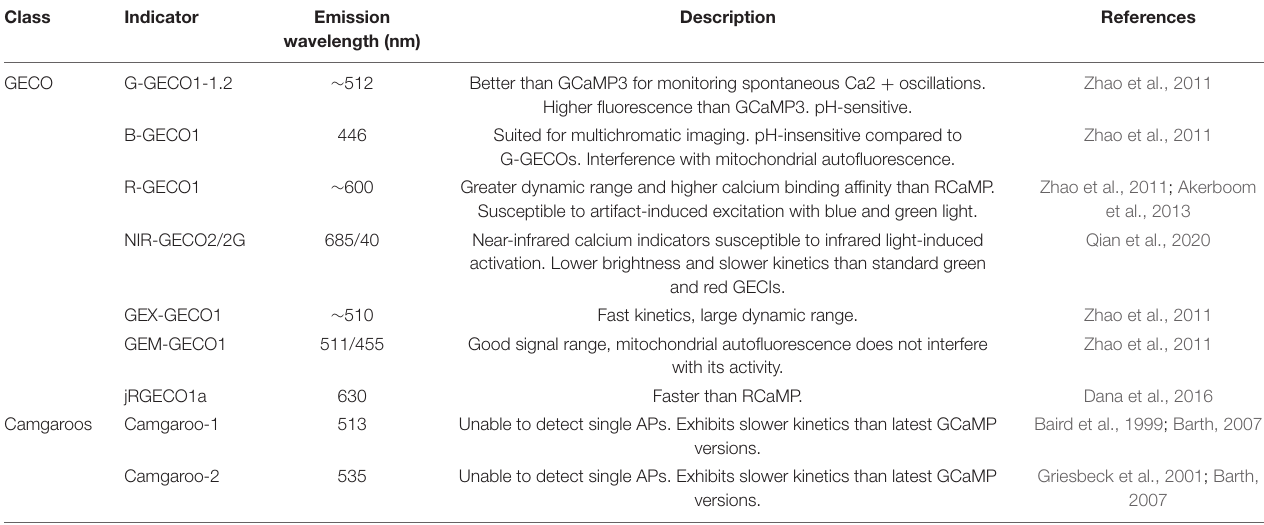
TABLE 3 | Non-GCaMP-based genetically encoded calcium indicators, including GECOs and